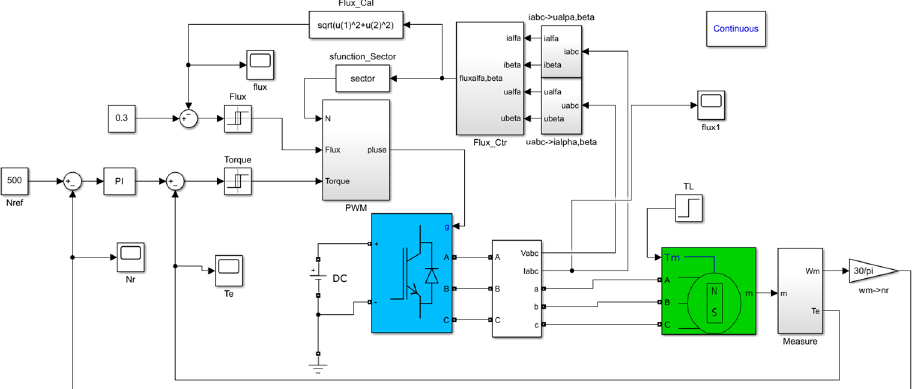
Figure 8. Simulation model of direct torque control based on sliding-mode control. The SVPWM module is modeled on the basis of space vector pulse modulation, as described in Section 3 and shown in Figure 9.